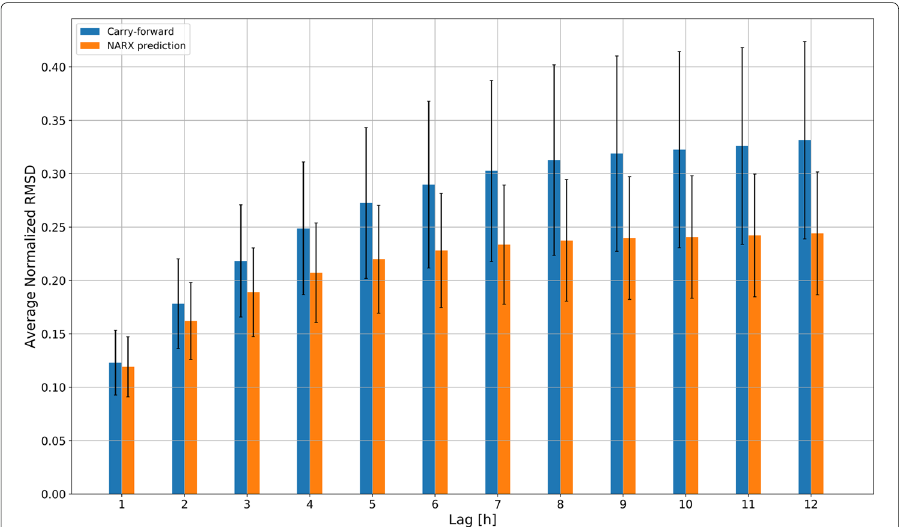
Fig. 4 Average normalized RMSD between the target time series and the forecast based on simple carry-forward (blue bars) and a NARX network (orange bars). Forecast time lags range from one hour to twelve hours. Errorbars denote the standard deviation of the normalized RMSD over the twelve different pairs of